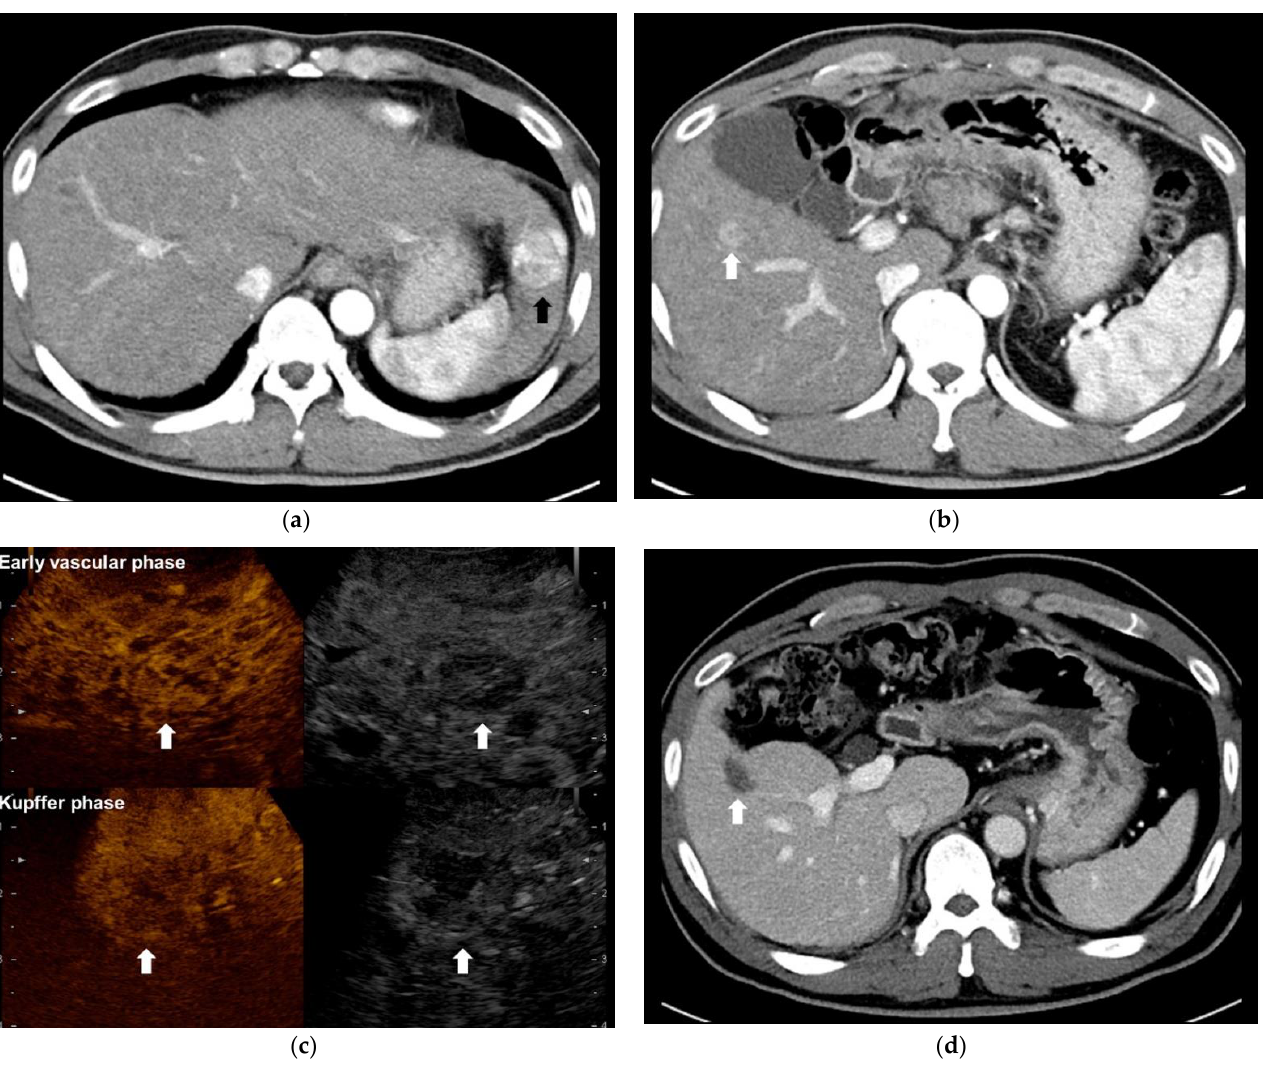
Figure 3. Images of a 39-year-old male patient with intermediate-stage HCC who underwent left lateral sectionectomy plus IORFA. ( a , b ) Contrast-enhanced CT images in the arterial phase, showing ( a ) a 3.6 cm HCC in liver segment 2 (black arrow), which was resected, and ( b ) a 1.2 cm HCC in liver segment 5 (white arrow), which could not be resected due to insufficient future liver remnant. ( c ) Sonazoid-enhanced US images during IORFA showing arterial enhancement with a Kupffer defect in liver segment 5 (white arrows). ( d ) CT image 8 years later showing no evidence of a viable HCC in the remnant liver with an RFA defect (white arrow).